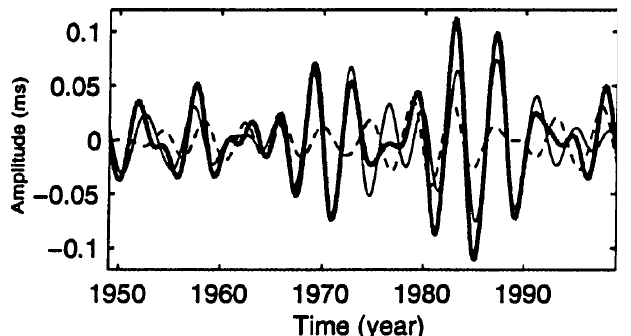
Fig. 14. Interannual variations at the triennial-quadrennial band (3 to 5 years) of AAM (i.e. TAAM ) ( bold ), polarward mode ( solid ), equatorward mode ( dashed ) Table 2. As for Table 1. Here for the TQO band only Data//band 3–5 MSOI and (PW+EW)